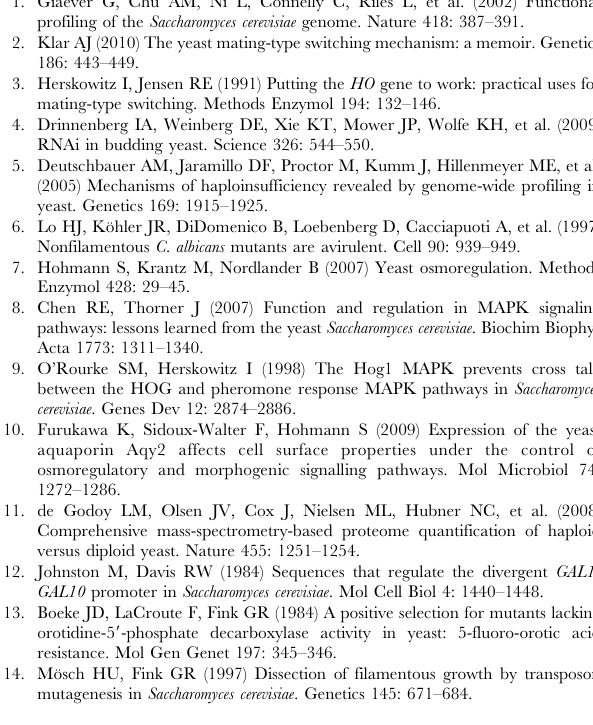
Figure S1 Confirmation of diploidized yeast strains by mating-type PCR. The mating-type PCR of MAT a , MAT a ,